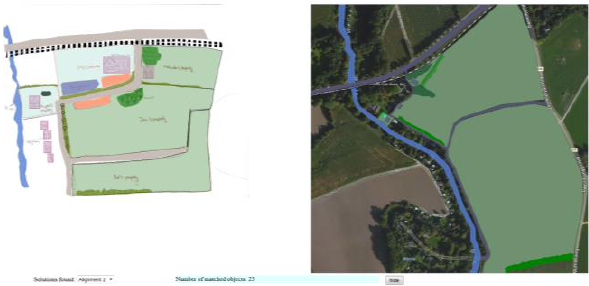
Figure 1. Prototype user interface for exploring possible alignments of a sketch map with a vector-raster overlay (http://chipofya.staff.ifgi.de/tech4land/alignment_demo.html)